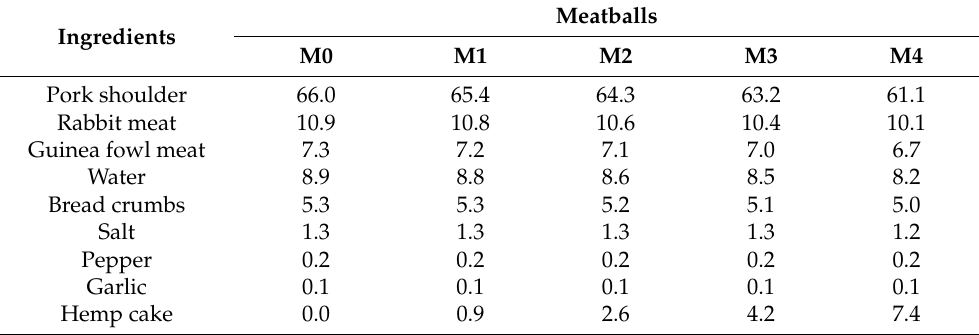
Table 1. Percentage composition of the five variants of meatballs.